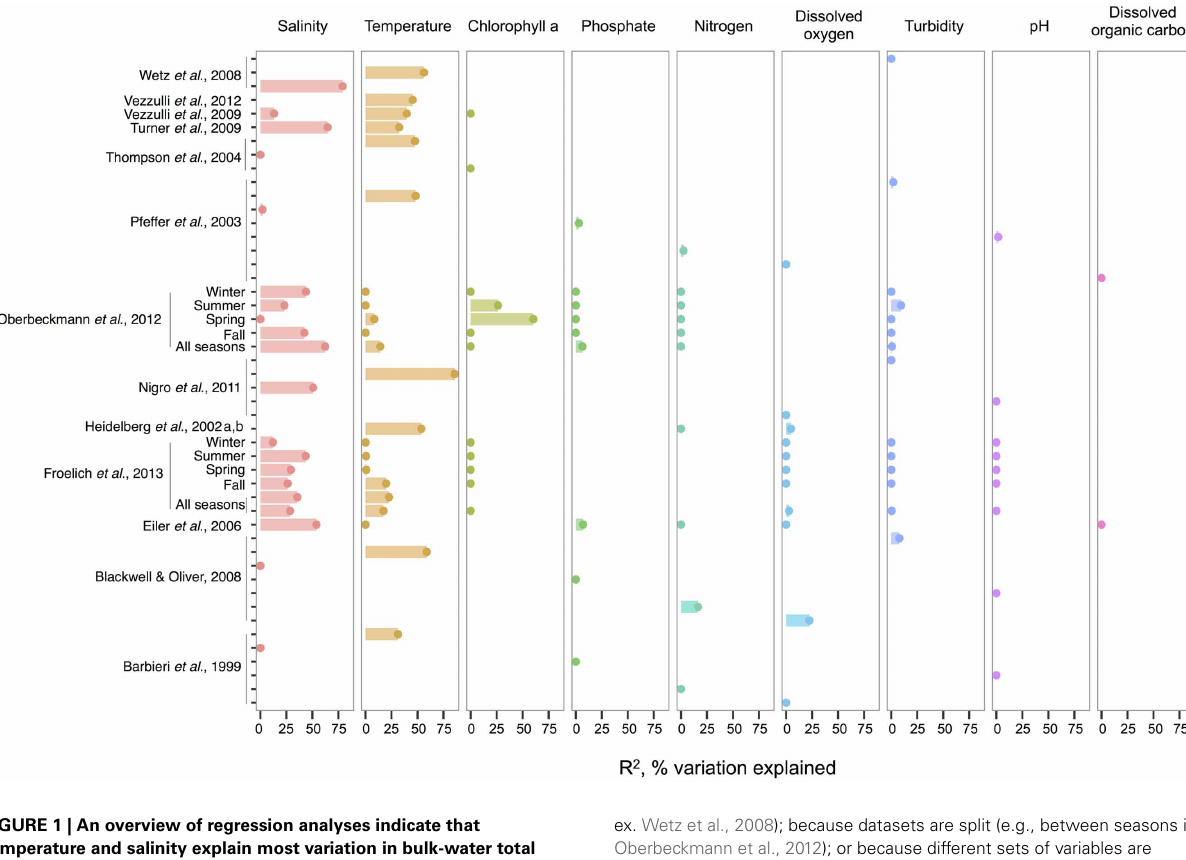
FIGURE 1 | An overview of regression analyses indicate that temperature and salinity explain most variation in bulk-water total Vibrio abundance. The R 2 , or pseudo- R 2 , values associated with regression analyses are shown for selected environmental variables that are well-represented across studies. An individual study may perform multiple analyses because variables are considered for correlation independently (for